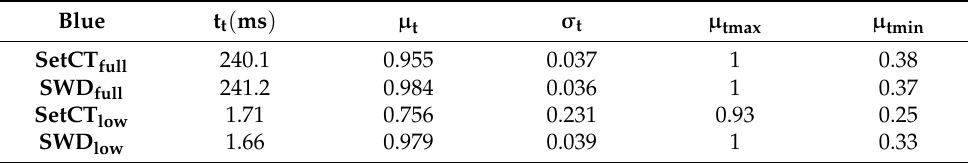
Table 3. Performance evaluation of the THz-FDS classification of a blue